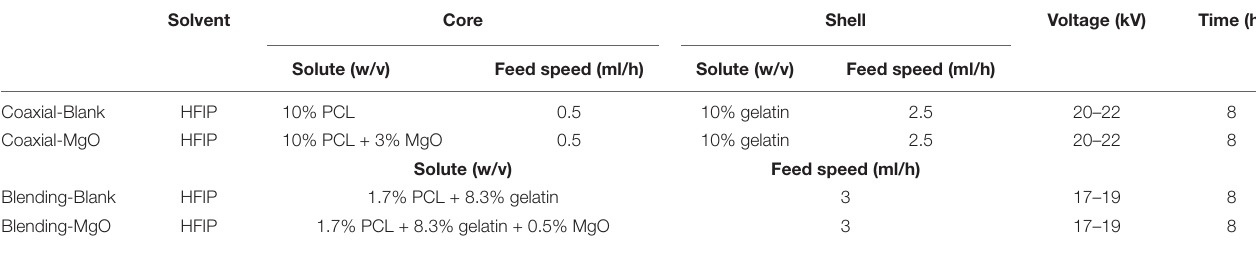
TABLE 1 | Parameters for electrospun fibers.